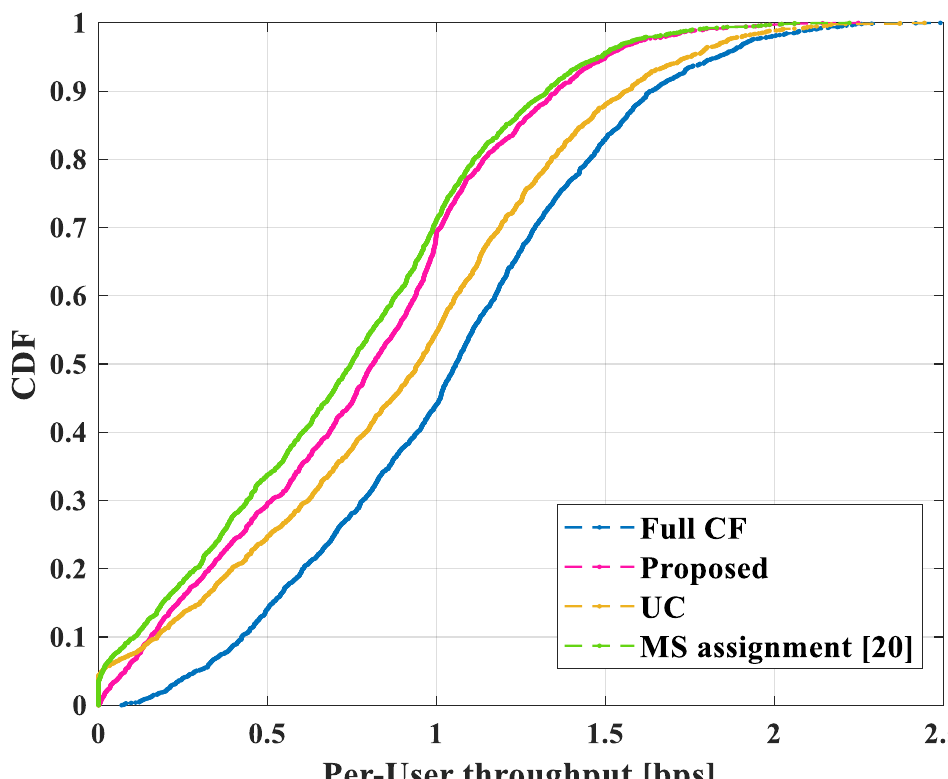
Figure 7. CDF of per-user throughput for four cases with two antennas.